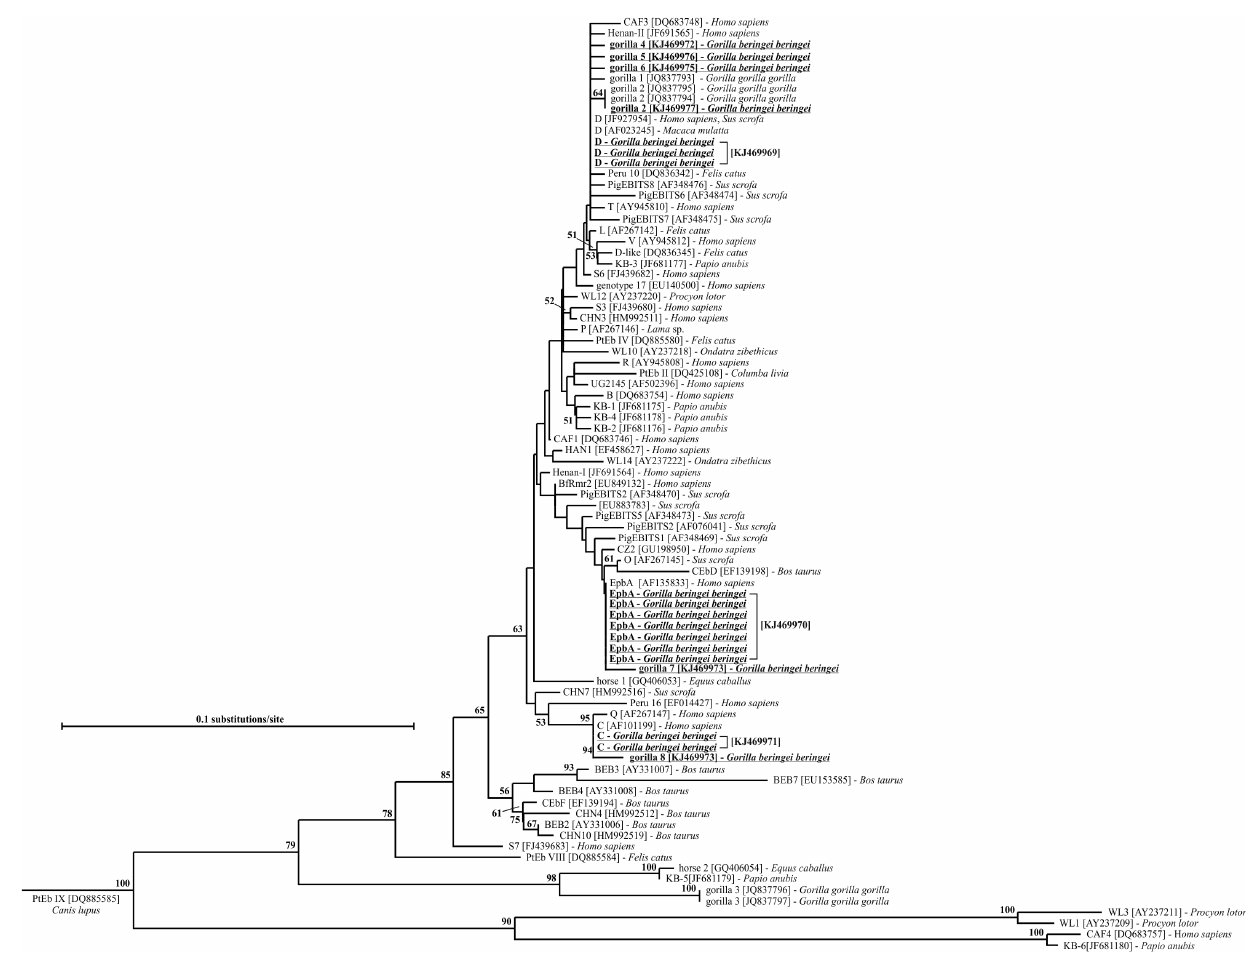
Figure 1. Neighbor-Joining tree based on nucleotide sequences of whole ITS region of Enterocytozoonbieneusi isolates, including our new sequences (underlined). The host is listed for each sample. Values on branches are percent bootstrapping using 1 000 replicates. The bootstrap proportions greater than 50% are shown at each branch. Nucleotide sequences generated from this study are underlined and are deposited in the GenBank under Accession Numbers KJ469967–KJ469979.